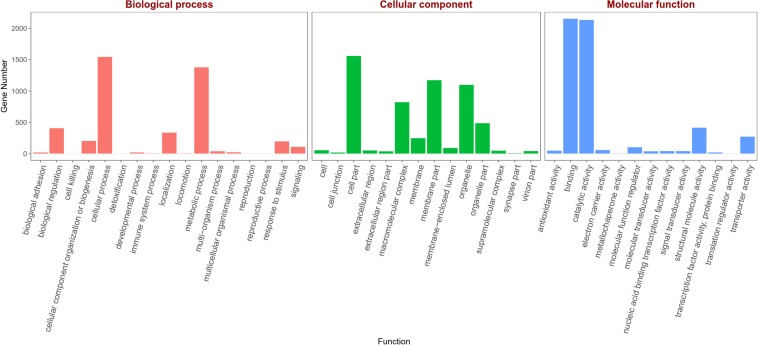
Gene Ontology (GO) classifications of legs transcripts annotated at GO level 2 according to the involvement in biological processes, cellular component and molecular function.